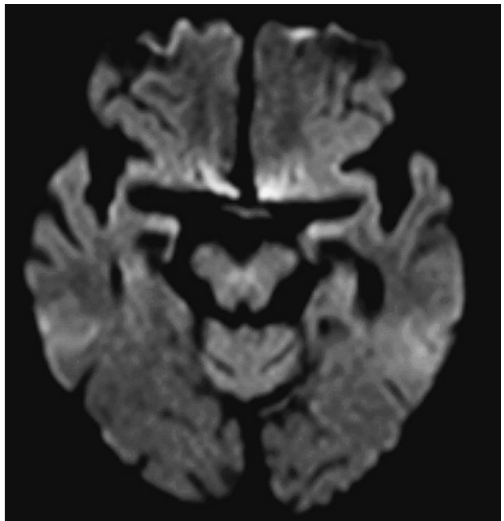
Fi g . 1 Ma g netic resonance ima g in g (MRI) of the patient. Axial diff u sion- w ei g hted ima g in g (D W I) taken 2 w eeks after epi- sode re v ealed onl y sli g ht ischemic chan g